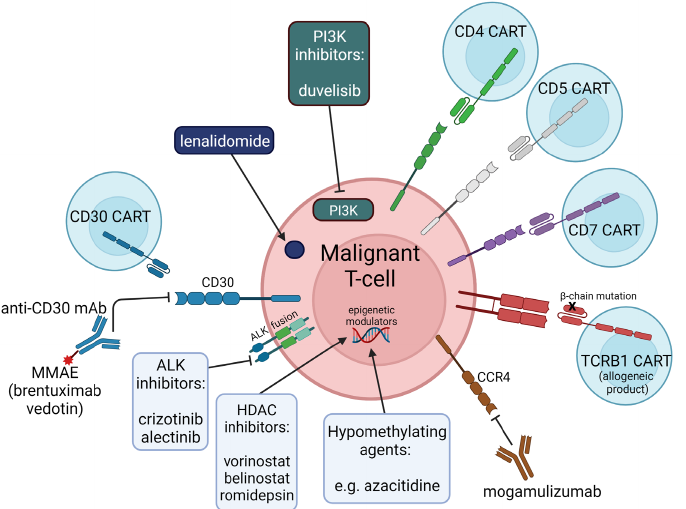
Figure 2. Schematic of novel biologic agents currently employed and potential future cellular therapies under development for clinical use against peripheral T-cell lymphomas. CAR = Chimeric antigen receptor, CART = CAR-T cell, MMAE = monomethyl auristatin E, HDAC = histone deacetylase, PI3K = phosphoinositide 3-kinase, TCRB1 = T-cell receptor beta chain 1, CCR4 = CC chemokine receptor 4.